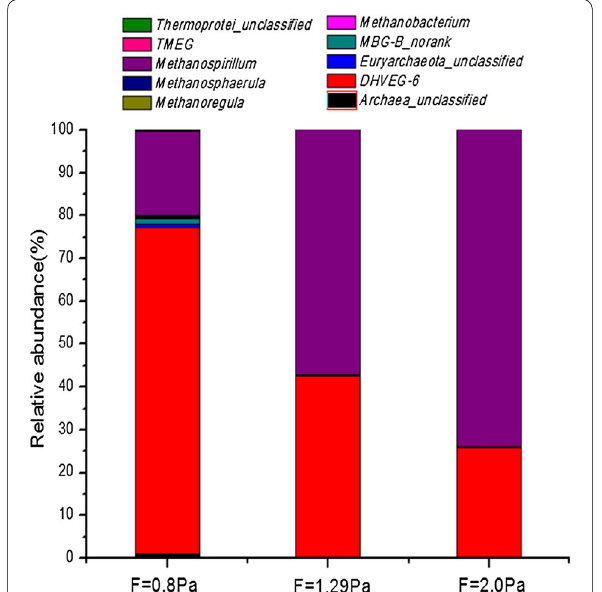
Fig. 5 The relative abundance of predominant bacterial phylum in mature biofilms, COD 400 mg/L. Nine classified archaea were = detected and listed in Table 1. Methanospirillum and DHVEG - 6 were both dominant in three biofilms. They both accounted for 96.02, 99.6 and 99.6%, respectively, at wall-shear stresses of 0.8, 1.29 and 2.0 Pa. The proportion of methanospirillum in this study increased with the increase of wall-shear stress, but DHVEG - 6 was decreased with the increase of wall-shear stress